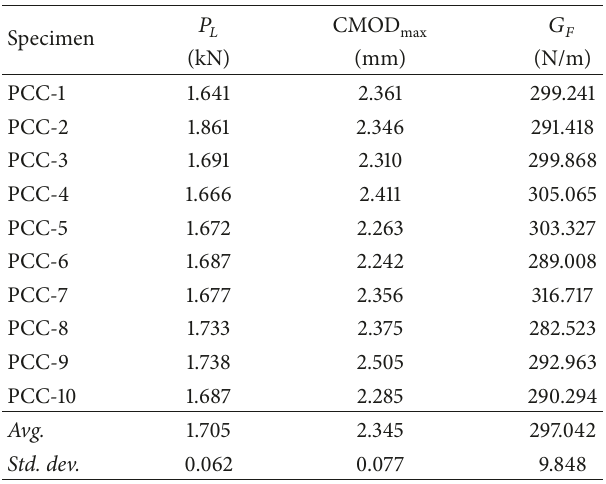
Table 5: Fracture energy for specimens of